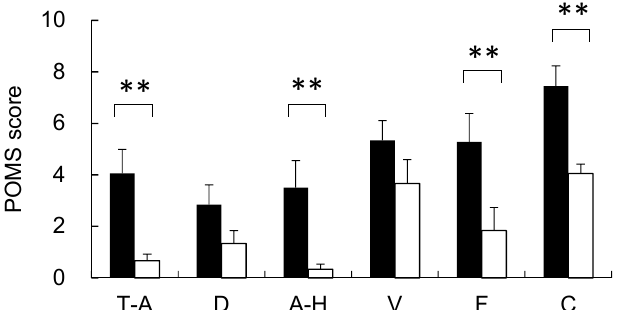
Figure 5. Comparison of the profile of mood states (POMS) scores between city and garden landscapes. T-A, tension-anxiety; D, depression; A-H, anger-hostility; F, fatigue; C, confusion; V, vigor; Mean ± standard error; N = 18; ** p < 0.01.